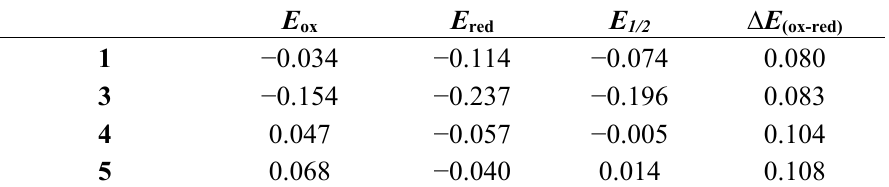
Table 2. Electrochemical data for the complexes (values in V).